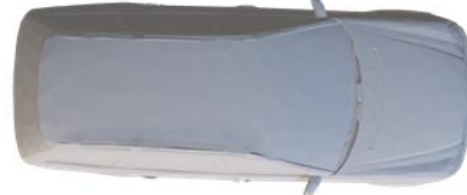
Figure 11. Car body (aluminum).